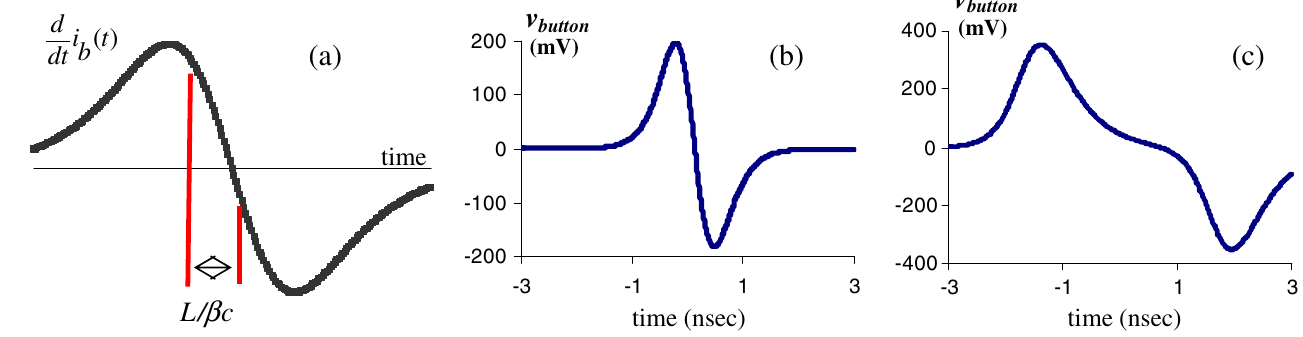
FIG. 4. (Color) (a) Simulation principle of the button current i button ð t Þ with respect to Eq. (4). (b) and (c) The response function, computed with a MATHEMATICA routine, of two different button lengths, L ¼ 10 and 120 mm for a typical bunch of (cid:5) seen ¼ 17 mm of the superconducting linac of Spiral2. The (b) response (electrostatic case) appears as derivative of the bunch seen. The (c) response is identical to the longitudinal bunch shape. The pulse is positive when the bunch is entering inside the electrode and negative when the bunch is leaving the electrode. The simulation allows the optimization of the electrode dimensions for any mode.